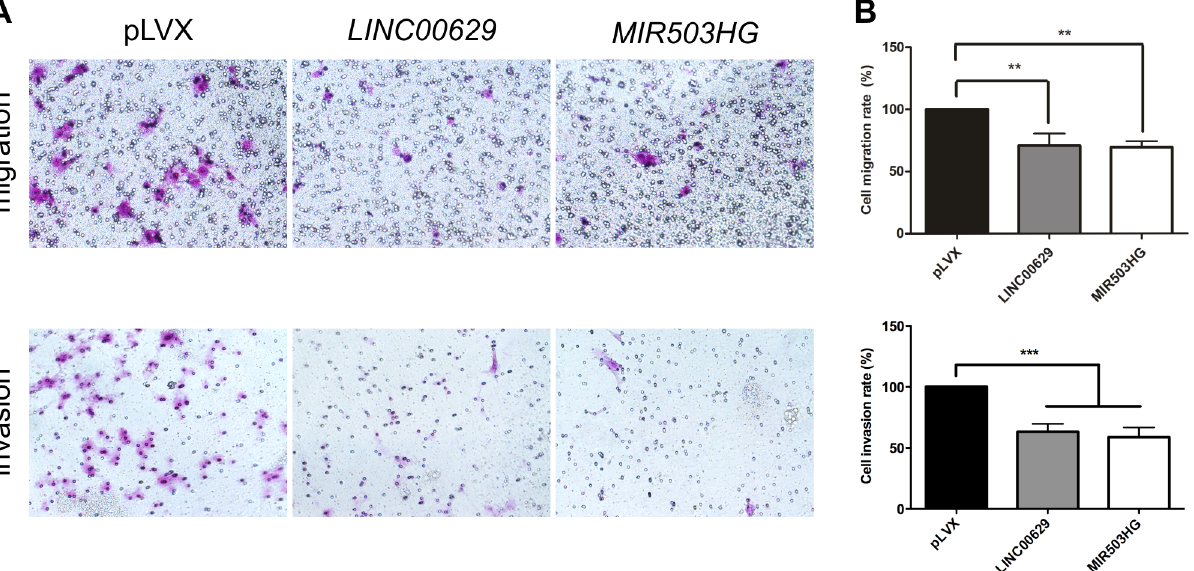
Fig 10. LINC00629 or MIR503HG2 overexpression decreased migration and invasion rates of JEG3 cell line. A. Representative figures from transwell migration (upper) and invasion assays (bottom) from cells containing empty (pLVX), MIR503HG2 or LINC00629 expression vectors. B. Graph bars are showing migration and invasion rates after 48 hours from transfection. The data represent the average of 2 or 3 experiments performed in triplicate. ** p < 0.01 and *** p < 0.001 (ANOVA followed by Bonferroni post-test).